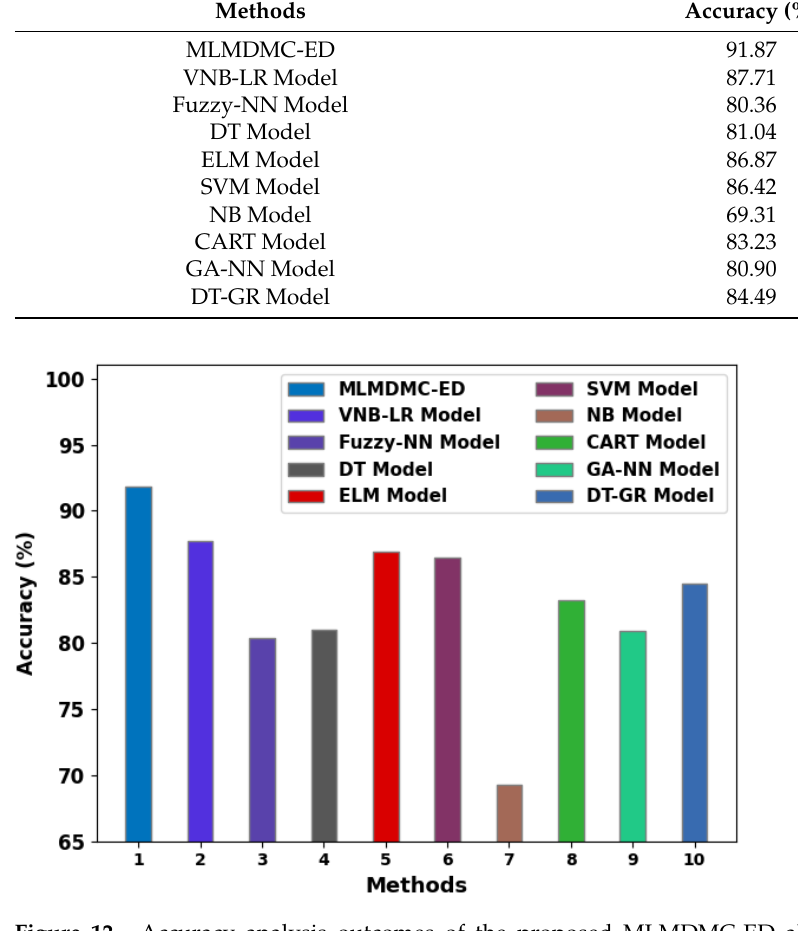
Figure 12. Accuracy analysis outcomes of the proposed MLMDMC-ED algorithm and other recent algorithms.